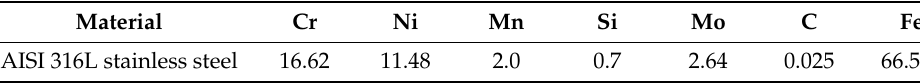
Table 2. Chemical composition of powder (wt.%).